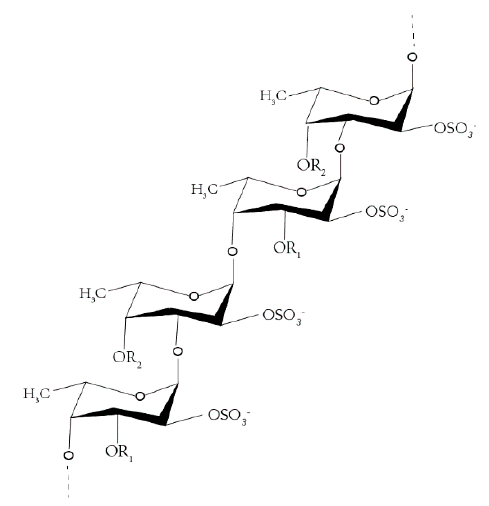
Figure 1. Fucoidan structure from Fucus vesiculosus .